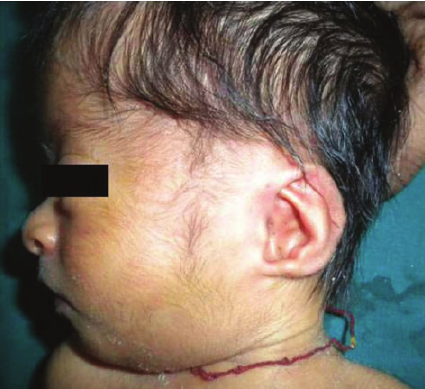
Figure 1: The photograph shows the facial features with downslant- ingpalpebralfissure,largeandlow-setearswithpreauricularpit,and micrognathia.